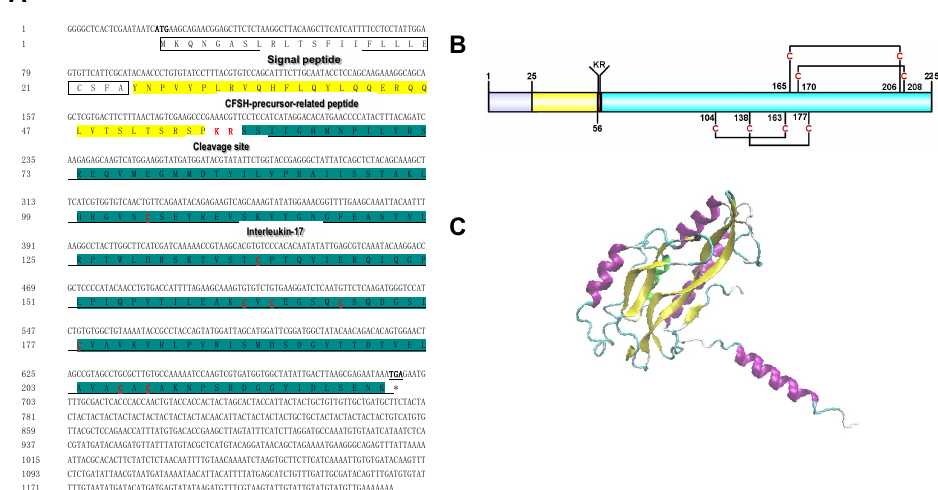
Figure 1. The molecular characterization of PtCFSH. ( A ) Nucleotide and amino acid sequences of PtCFSH. Bolded markers are the nucleotide and amino acid sequences encoding the start codon (ATG) and * indicates termination codon (TGA). Predicted signal peptide sequences and the CFSH- precursor-related peptides are shown in white and yellow boxes, respectively. The cleavage site “KR” is marked in red. The major domain interleukin-17 is marked with a green box and underlined, and the 8 cysteines are marked in red. ( B ) Structure description of PtCFSH. The ORF contains four different structures, the purple box is the signal peptide, the yellow box is the precursor-related peptide, the red box is the cleavage site “KR”, and the blue box is the interleukin-17domain containing four disulfide bonds. ( C ) The putative 3D structure of mature PtCFSH predicted by the Alphafold2.